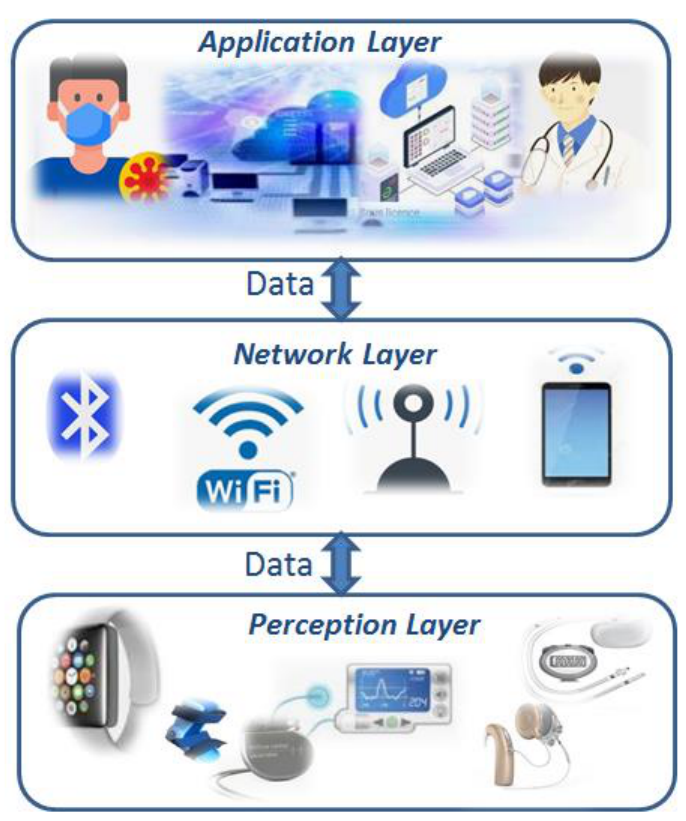
Figure 1. IoMT Figure 1. IoMT architecture.